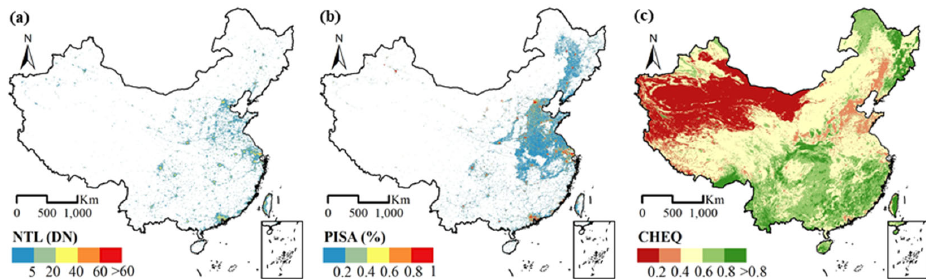
Figure 1. The spatial distribution of ( a ) NTL, ( b ) PISA, and ( c ) CHEQ in the year 2018.